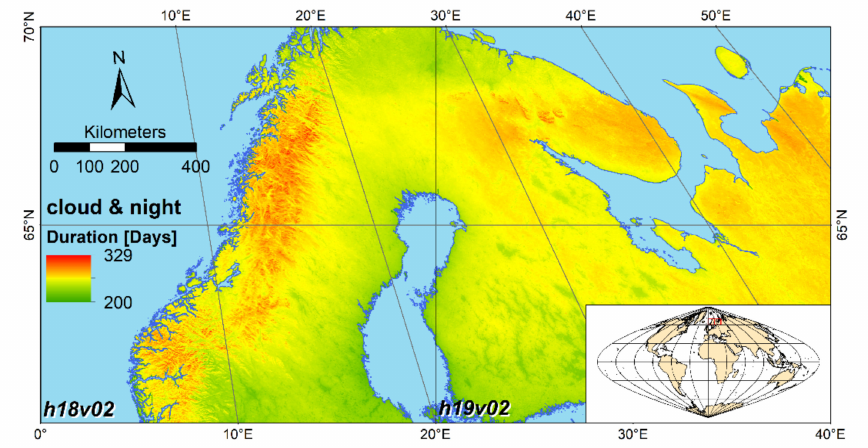
Figure 1. Number of days that are either influenced by clouds and polar night (arithmetic mean of the hydrological years 2001 to